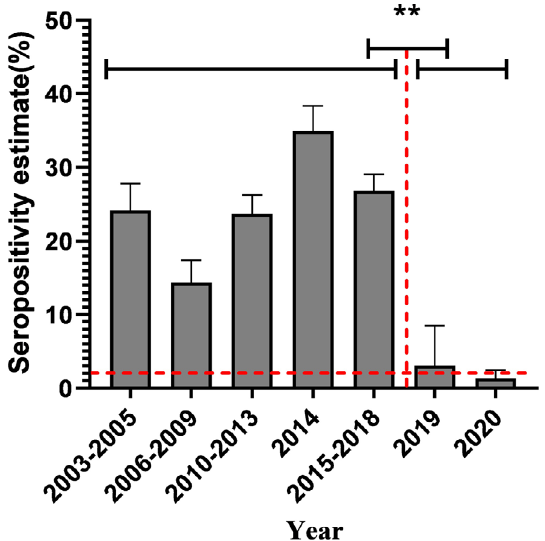
Figure 2. Comparison of seroprevalence of T. gondii in swine from four provinces before and after 2018. The four provinces were Henan, Shaanxi, Anhui and Shanxi. Data were obtained from Dong et al. [4] and Dubey et al. [8]. ** p <